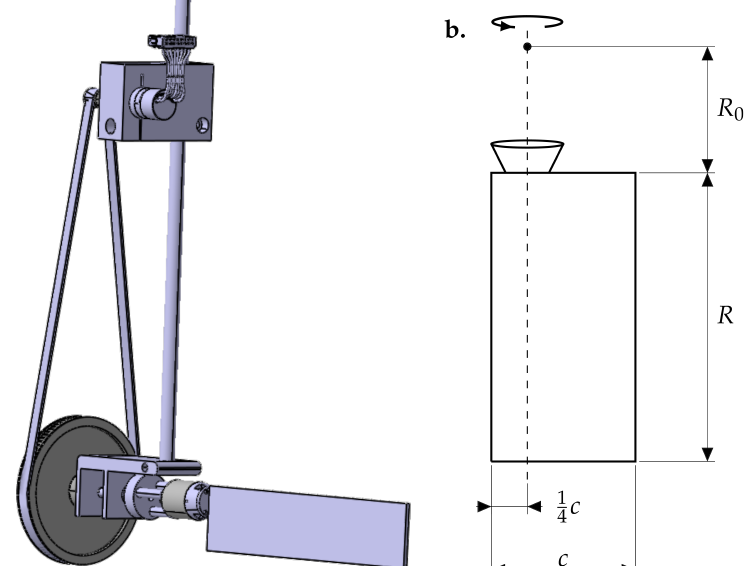
Figure 2. ( a ) Flapping wing mechanism. The main shaft controls the stroke motion. Through a belt transmission, the pitching motion is controlled at the bottom of the main shaft. ( b ) Wing model with chord c , span R , root cutout R and a rotational axis at quarter chord indicated by the dotted 0